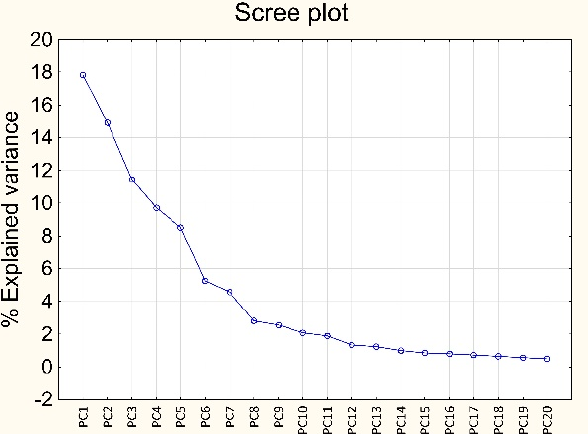
Figure 3. Results of PCA on the overall dataset in first derivative: scree plot.